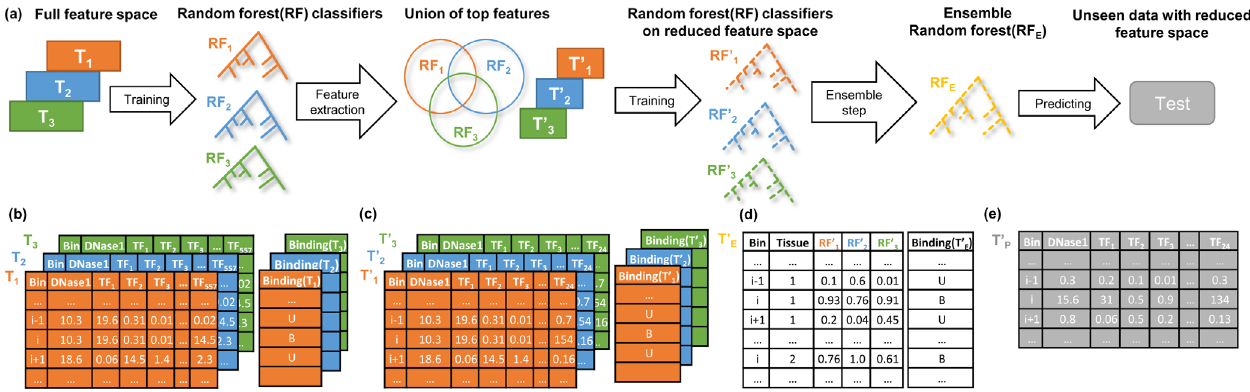
Figure 2. a ) An overview of model training for a distinct transcription factor, TF, with multiple training tissues. Using the full feature matrices T , T , T , depicted in ( b ), TF and tissue-specific random forest (RF) classifiers are trained. From those RF classifiers ( RF 1 2 3 determine the union of the top 20 features from each RF. In this example, the union of top TFs is comprised of 24 TFs. Next, we design reduced tissue-specific feature matrices T ’ , T ’ , T ’ , as shown in ( c ) based on the union of the top TF features. Subsequently, tissue-specific 1 2 3 RF classifiers ( RF ’ , RF ’ , RF ’ ) are trained on these reduced feature sets. The tissue-specific RF classifiers are applied to all training tissues 1 2 3 and their predictions are aggregated to form the feature matrix T’ , visualized in ( d ), which is used to train an ensemble model ( RF E testing phase the feature matrix T ’ is fed to the trained ensemble model RF to predict the labels for the unseen data ( e ). Note that the column p E Tissue in d ) is not included in the model but only shown here for illustration purposes. The feature matrices shown represent feature setup (1) using DNase1 Hypersensitive (DHS)